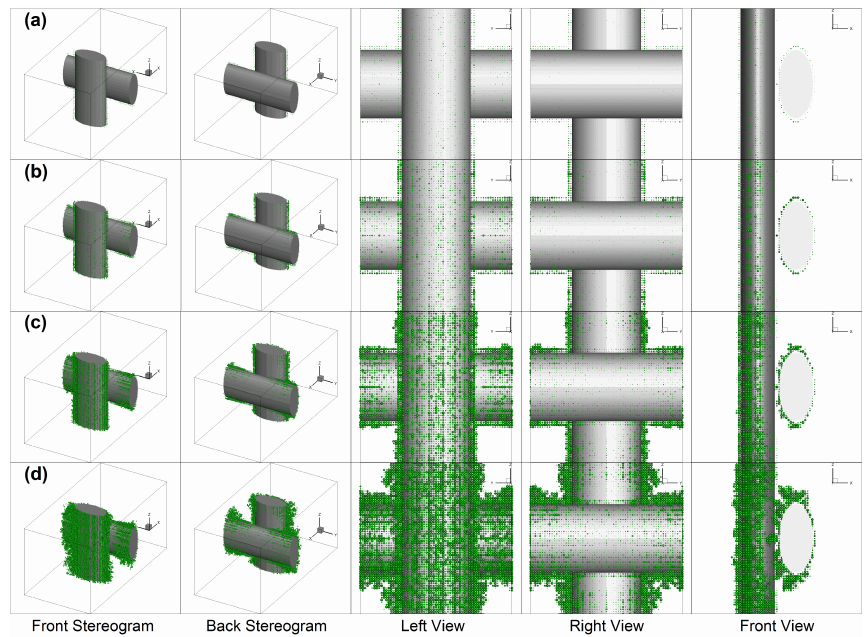
Figure 5. Growth process of dendrite structures of Case 2: ( a ) number of captured particles is 9176; ( b ) number of captured particles is 25,407; ( c ) number of captured particles is 58,442; ( d ) number of captured particles is 132,253.